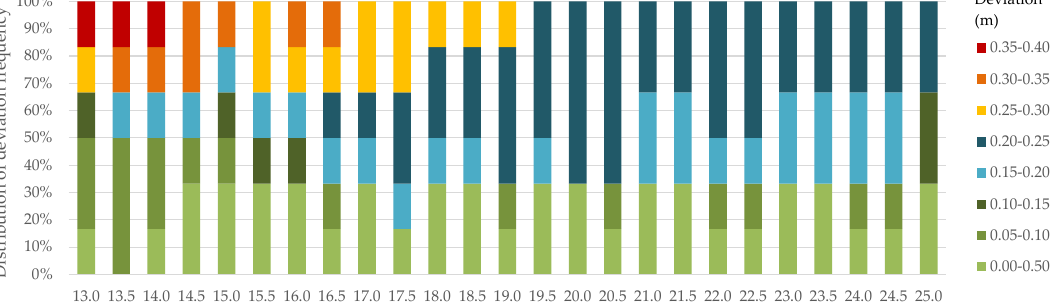
Figure 14. Distribution of deviation frequency for right-hand-side trajectories at cross-sections 11–13.